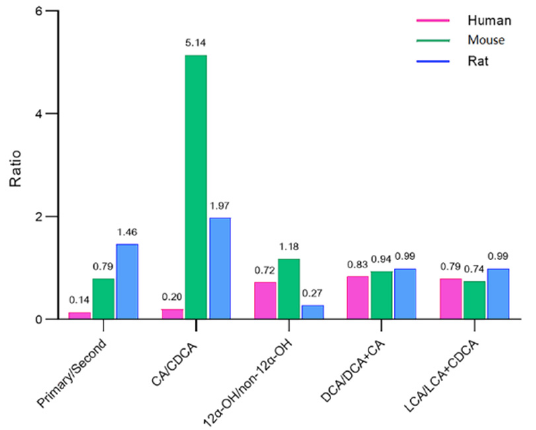
Figure 5. Bile acid indices in humans, rats, and mice.